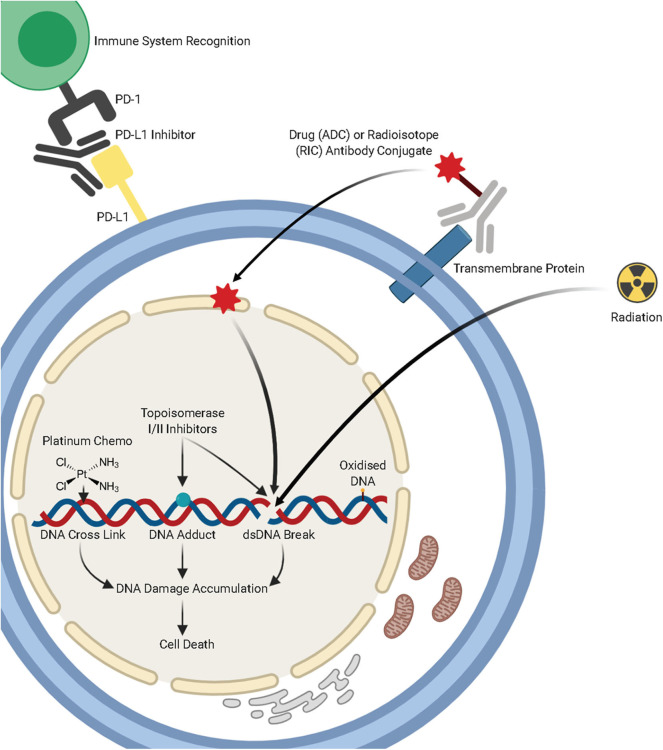
A summary of lung cancer treatments, including chemotherapy, radiotherapy, immunotherapies, and antibody-drug conjugates and the mechanisms by which they target DNA damage repair pathways. Figure created with Biorender.